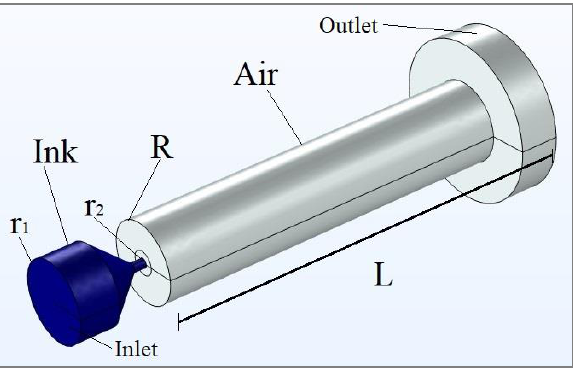
Figure 1. Inkjet printhead nozzle geometry. A droplet is formed by jetting a fixed amount of ink into an air-filled cylindrical printing chamber with a length L = 1 mm and a radius R = 0.1 mm. The radius of the jetting channel is equal to r 1 = 0.1 mm. The initial circular shape and the cross-sectional radius r 2 = 12 µ m of the droplet are predefined by the channel shape and size. The waveforms are generated by the top inlet of the nozzle by applying the fluid intake velocity and various waveform dwelling times. Different waveforms dwelling times are shown at Figure